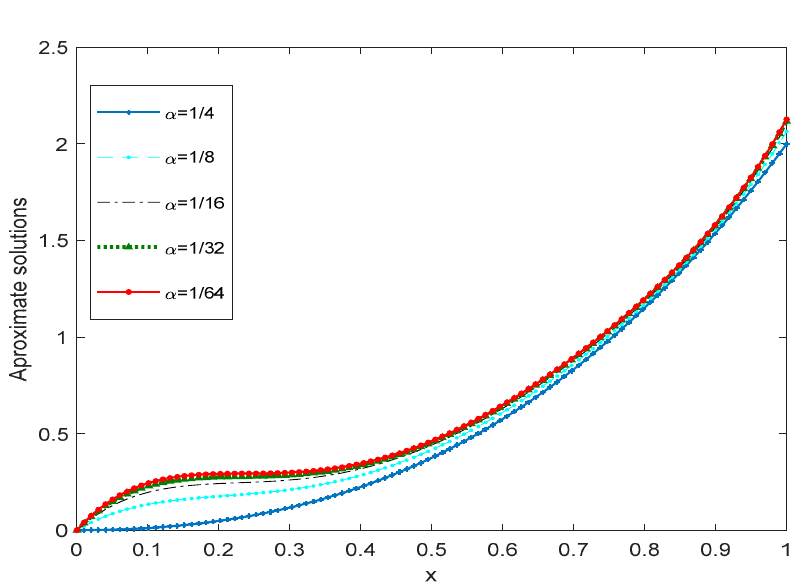
(cid:2869) , and 𝑅 = 3. , and 𝑅 = 3. , and R = 3. Figure 3. Plot of MAE of Example 2 for 𝛼 = (cid:2872) (cid:2872) 4